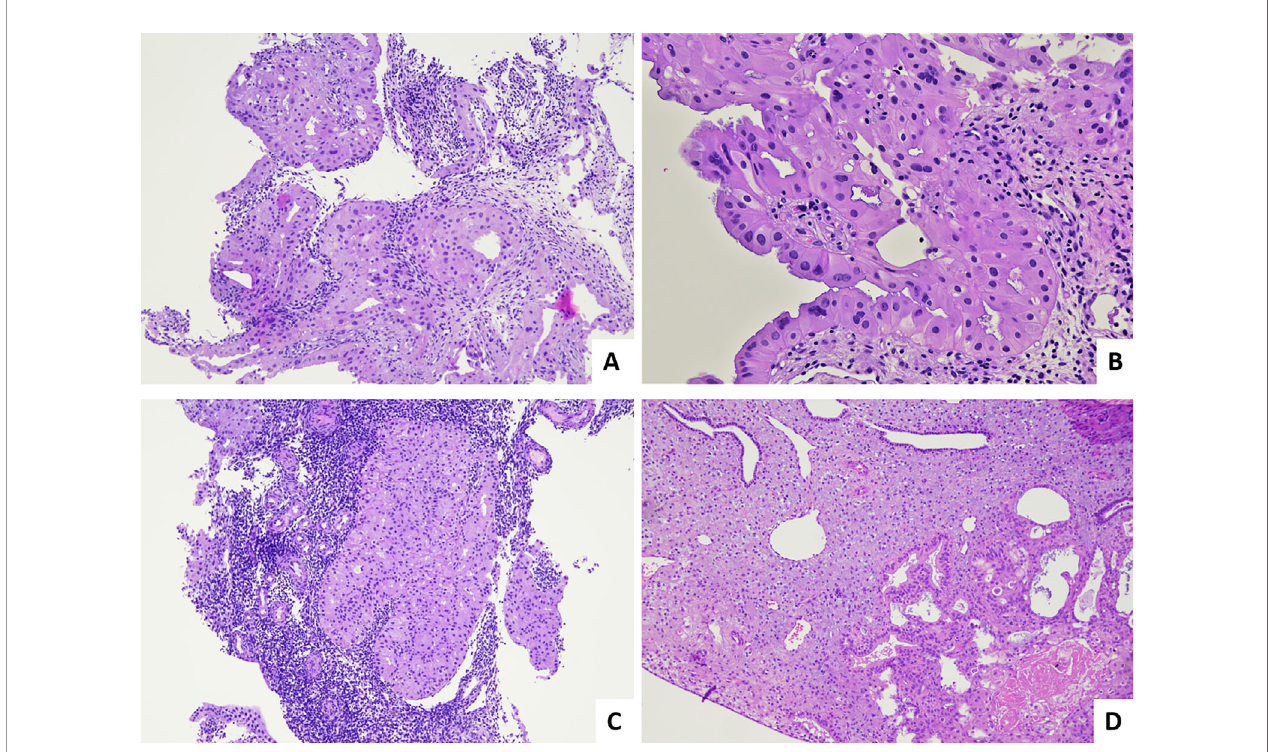
FIGURE 3 | Pathological evaluation of post hormonal fertility-sparing therapy bioptical samples for AH and WDC. (A) Fragment of endometrial tissue with persistence of AH such as on the previous biopsy (H&E; 4×). (B) Higher magni fi cation of sample in A, with evidence of residual nuclear atypia and presence of abundant eosinophilic cytoplasm (H&E; 40×). (C) Fragment of endometrial tissue with persistence of EEC such as on the previous biopsy (H&E; 4×). (D) Endometrial tissue with a focus of residual AH, in a context with pseudodecidualized stroma (H&E;